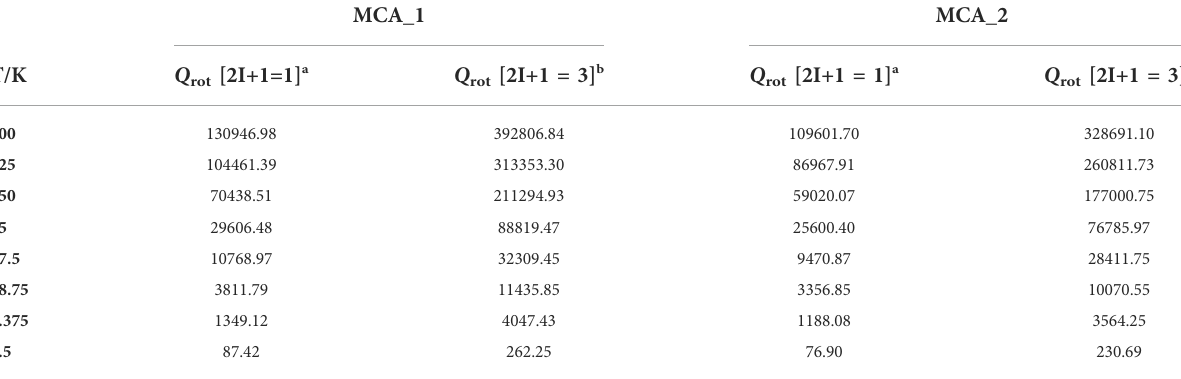
TABLE 3 Rotational partition function (Q rot ) calculated across the standard temperatures implemented in the JPL database (Pickett et al.,